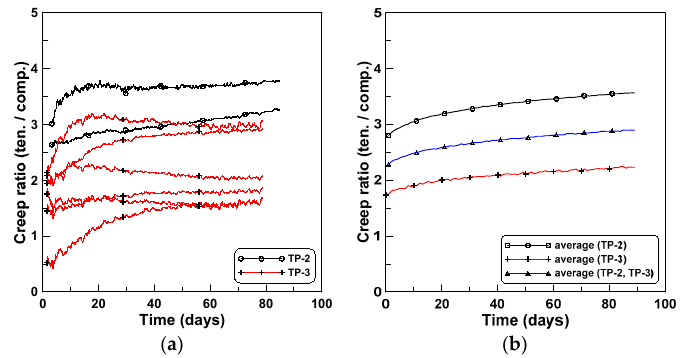
Figure 13. Ratios of tension creep to compression creep for TP-2 and TP-3 test series: ( a ) ratios for eight specimens of TP-2 and TP-3 and ( b ) average ratios of each test series. Materials 2019 , 12 , x FOR PEER REVIEW